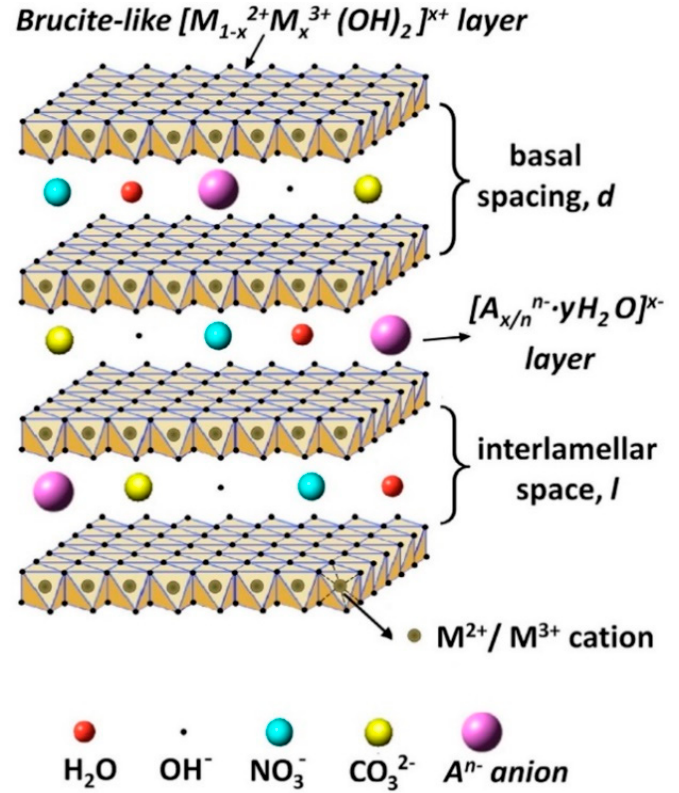
Figure 1. The general crystal structure of layered double hydroxide (LDH) film. Reprinted with permission from ref. [18]. Elsevier 2019.